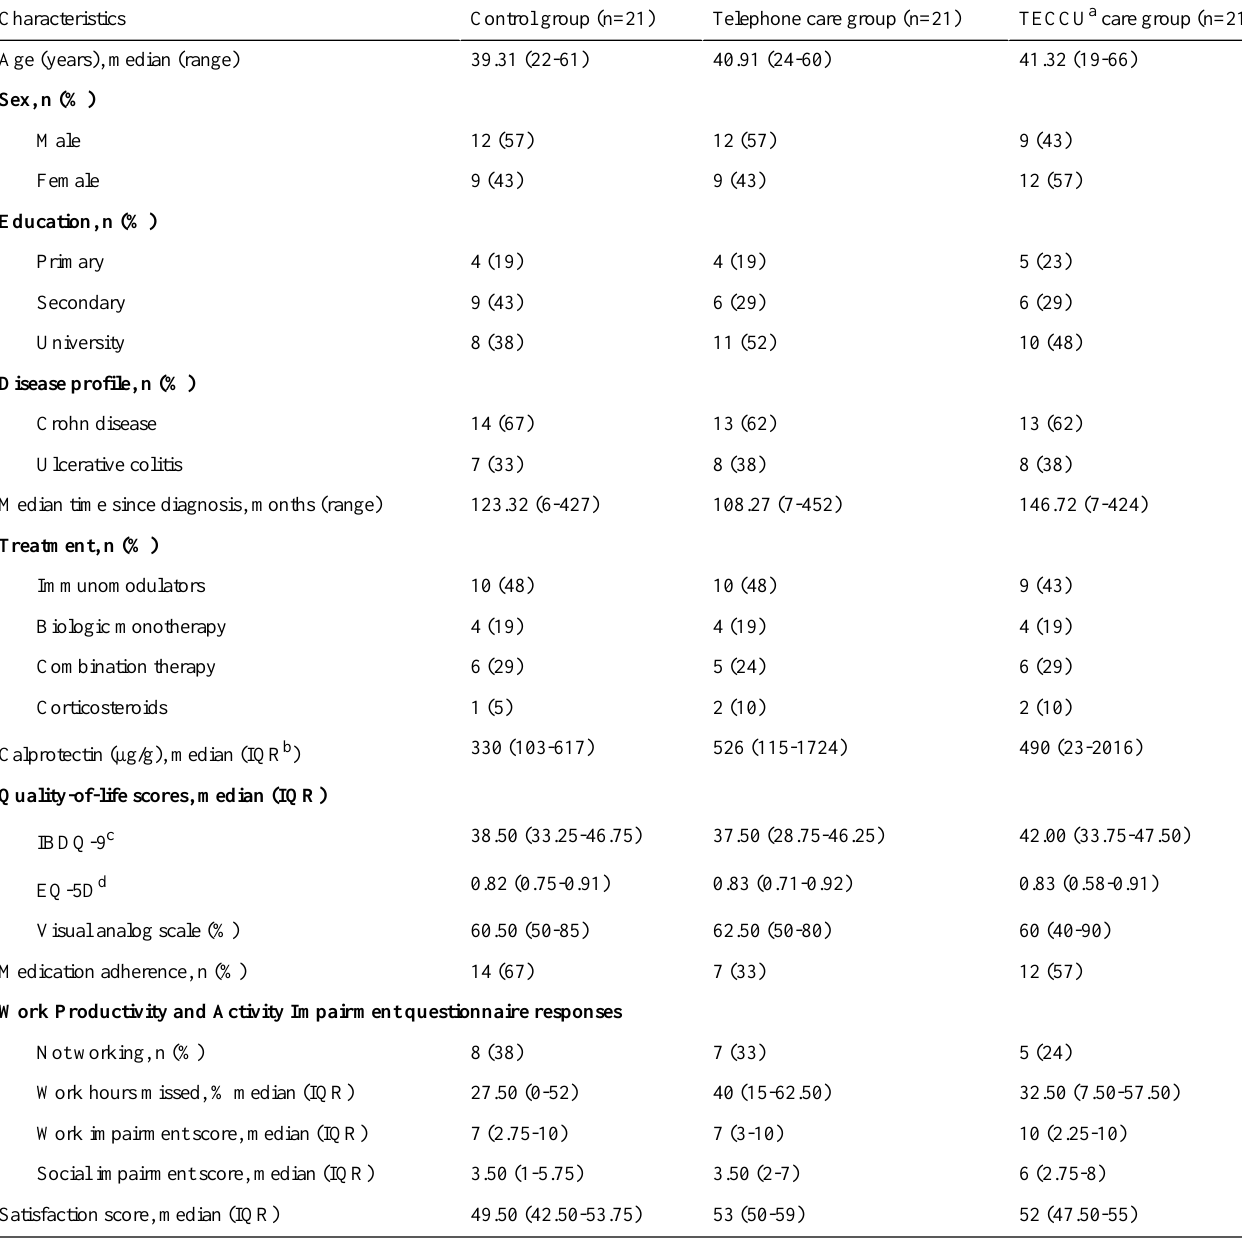
Table 1. Patients’baseline characteristics.